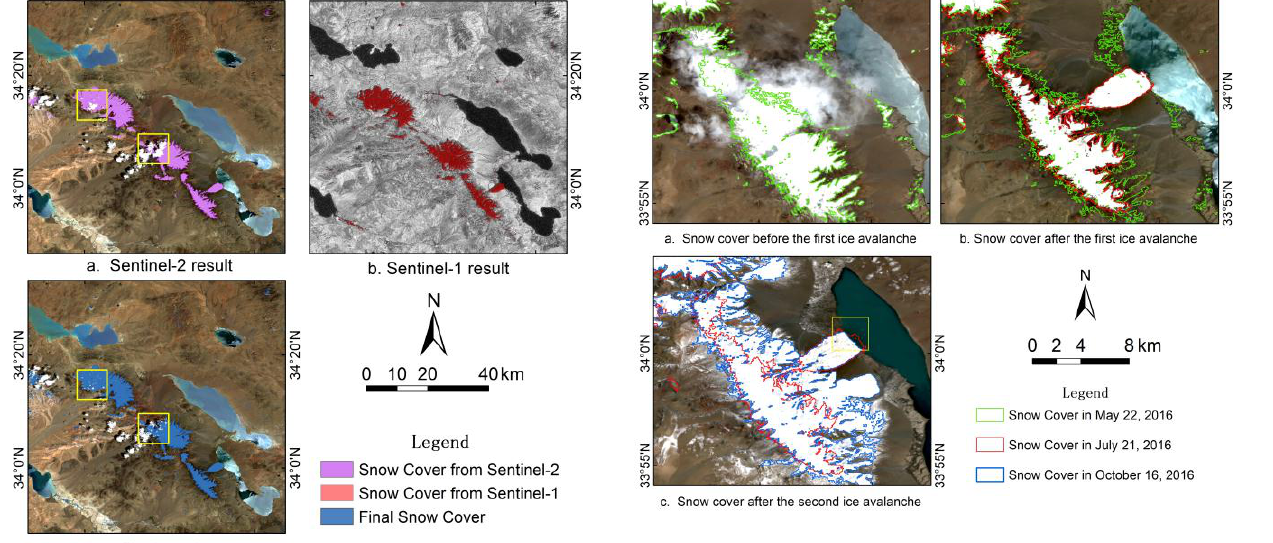
Figure 6. Snow cover changes during the ice